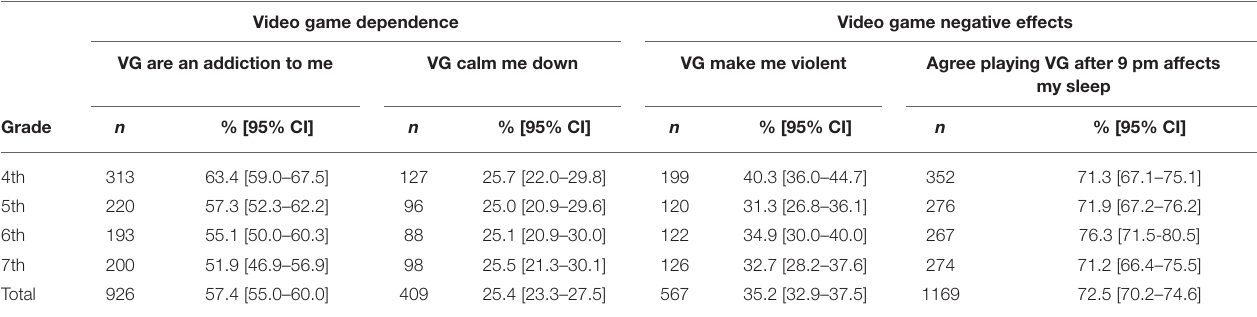
TABLE 5 | Perception of indicators of dependence on video games and negative effects of video games ( n = 1,630; Missing data =